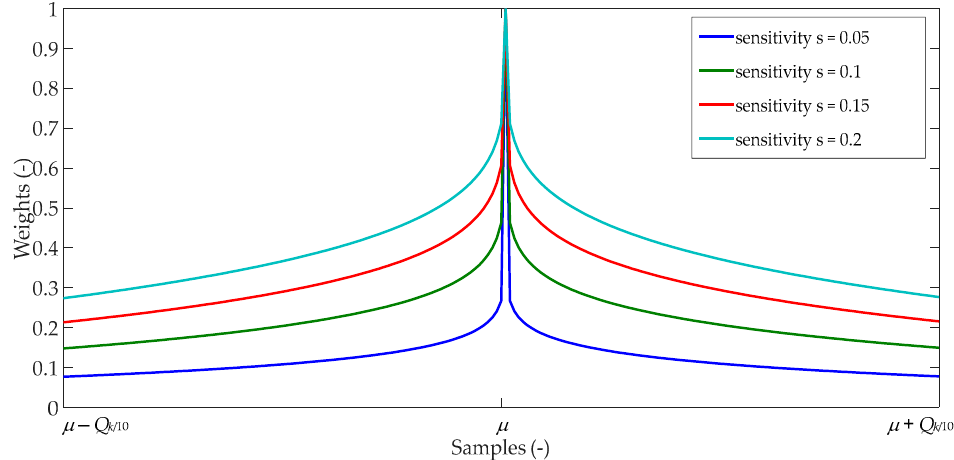
Figure 5. The assignment of weights by using the Power function in Equation (6) as the membership function.